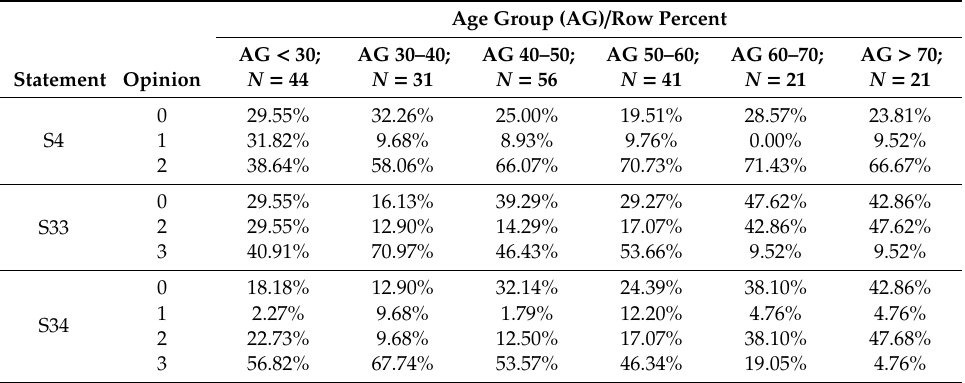
Table 2. Age as a factor significantly influencing opinions and attitudes to AAT.